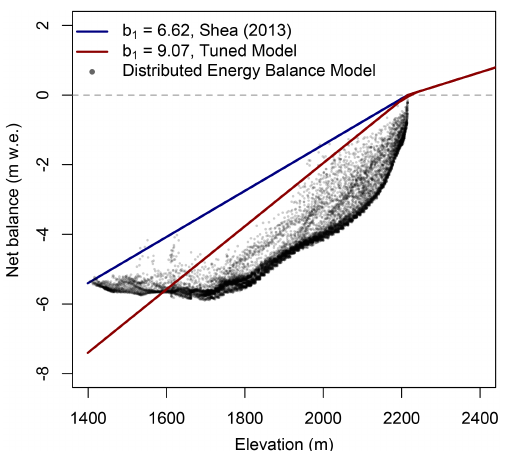
Figure 6. Modelled mass balance gradient from Shea et al. (2013) and a tuned coefficient using distributed energy balance modelling from the 2013 melt season.